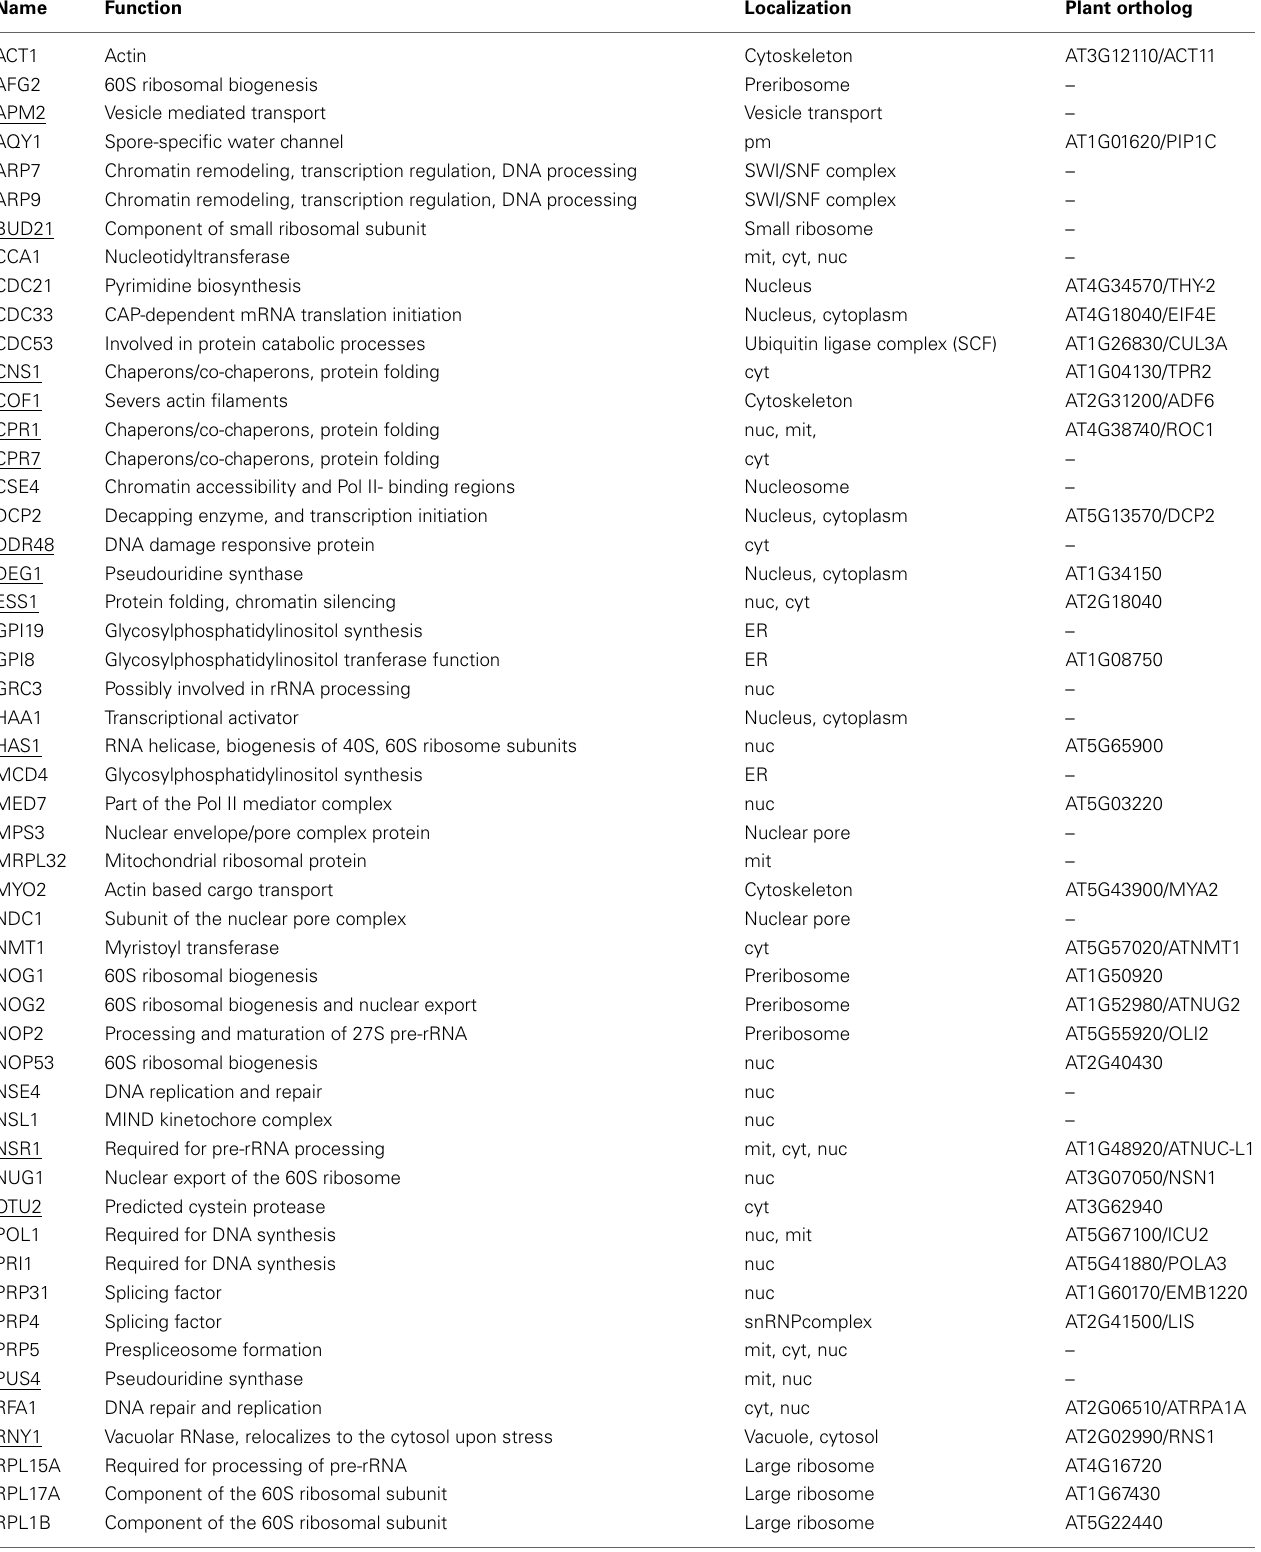
Table 1 | List of yeast CIRFs identified for tombusviruses based on high throughput yeast